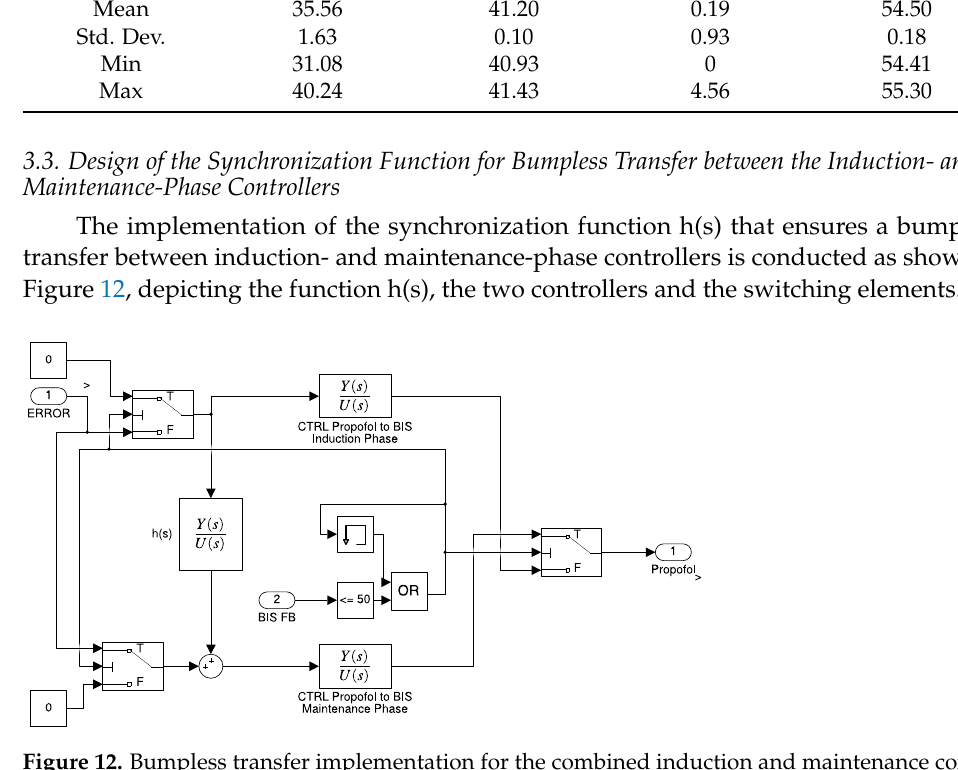
Figure 13. Propofol control signal for the two synchronized controllers (blue—induction, orange— maintenance). Table 5. Final induction-phase performances for each patient. Patient